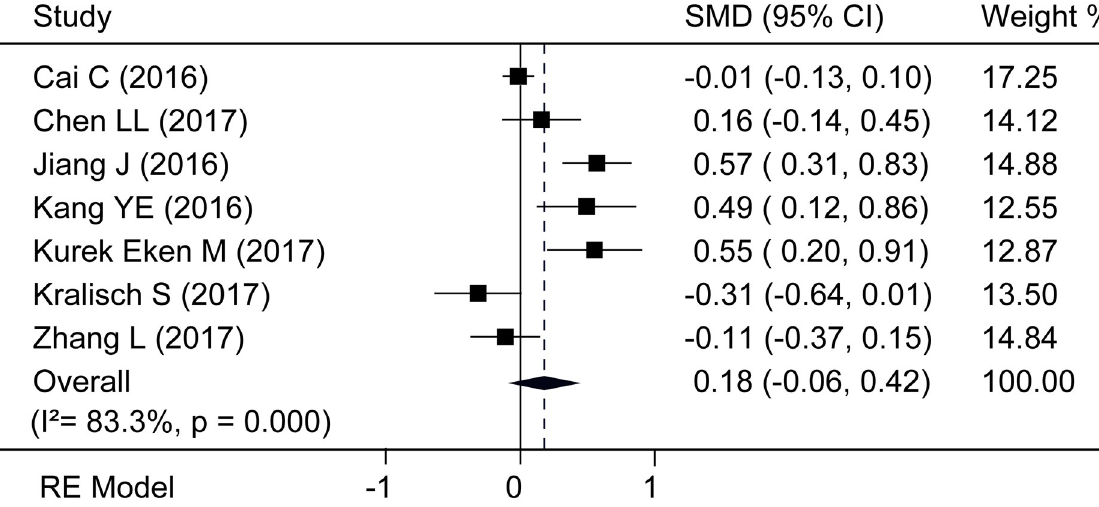
Fig 2. Forest plot of the association between circulation Nrg4 levels and DM; RE Model, random-effect model.